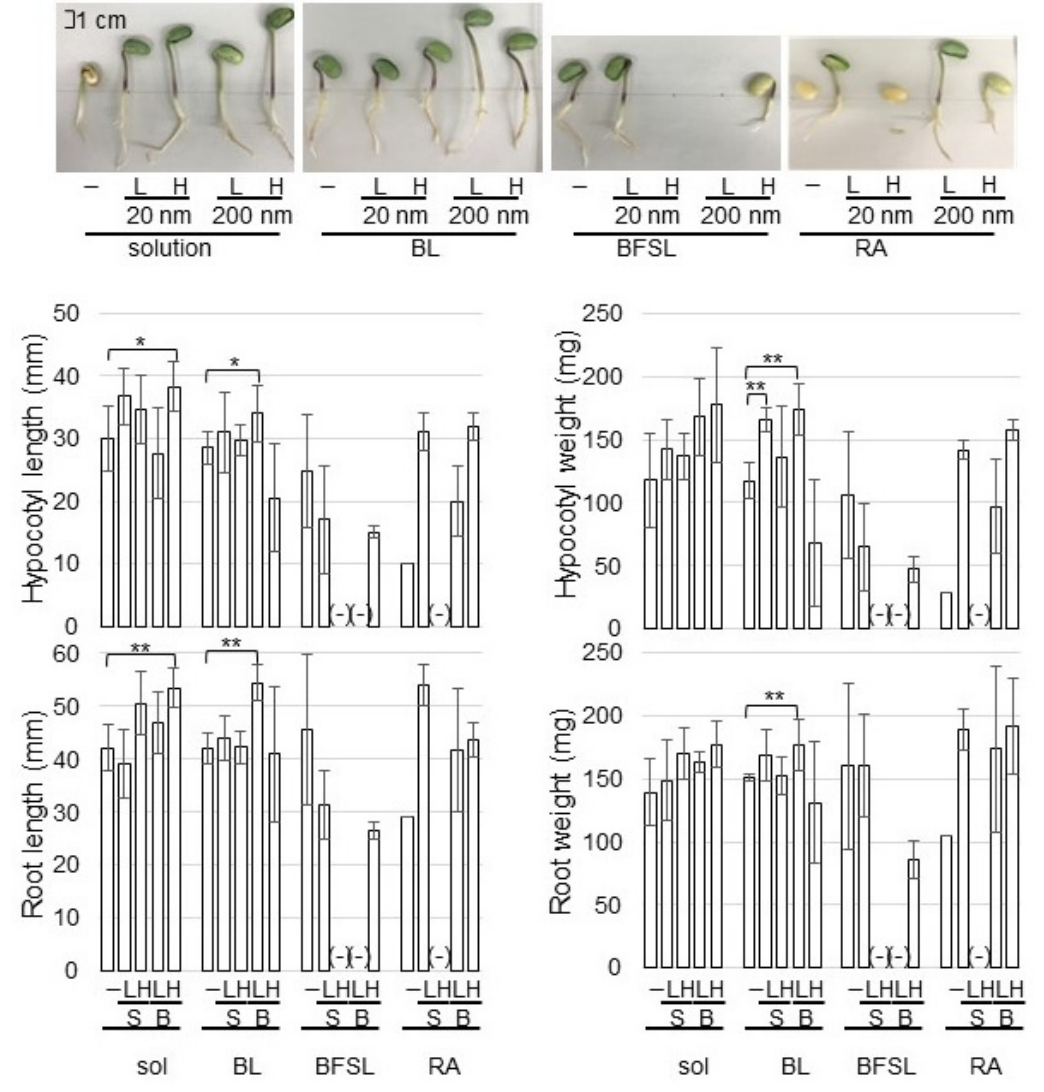
Figure 1. Effects of ZnO NPs on the morphology of soybean seedlings. Silica sand was treated with or without 1 ppm (L) and 10 ppm (H) ZnO NPs with 20 nm (S) and 200 nm (B) before sowing. When fibers of BL, BFSL, and RA crosslinked with or without 0.15 mg and 1.5 mg of ZnO NPs of 20 nm (S) and 200 nm (B) were used, 150 mL of water was supplied in the silica sand, which become 1 ppm (L) and 10 ppm (H) as final concentration. After sowing, four-day-old soybeans were collected and main-root length, total root-fresh weight, hypocotyl length, and hypocotyl-fresh weight were measured as morphological parameters. The scale bar in the photograph indicates 1 cm. “-” means nontreated soybean for each group as control. Data are presented as the mean ± S.D. from three independent biological replicates. Asterisks indicate significant changes between two treatments according to Student’s t -test (** p < 0.01; * p <